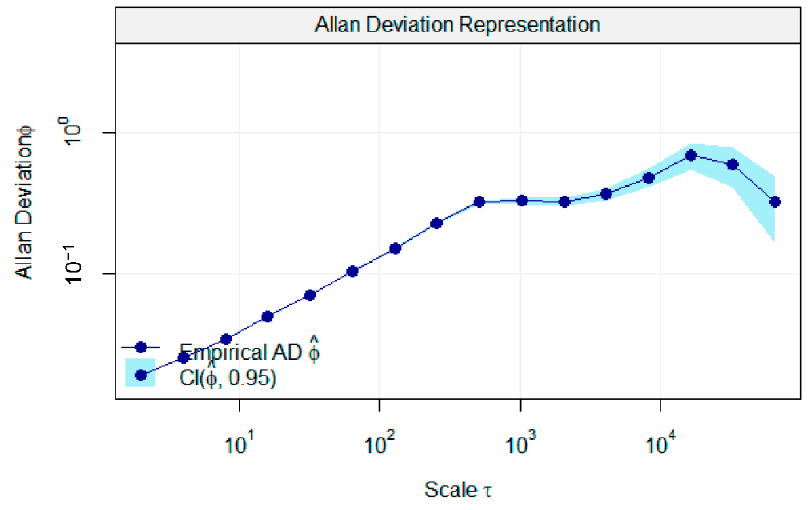
Figure 7. Allan deviations of instrument output at a 7.7 ppm N 2 O gas concentration.